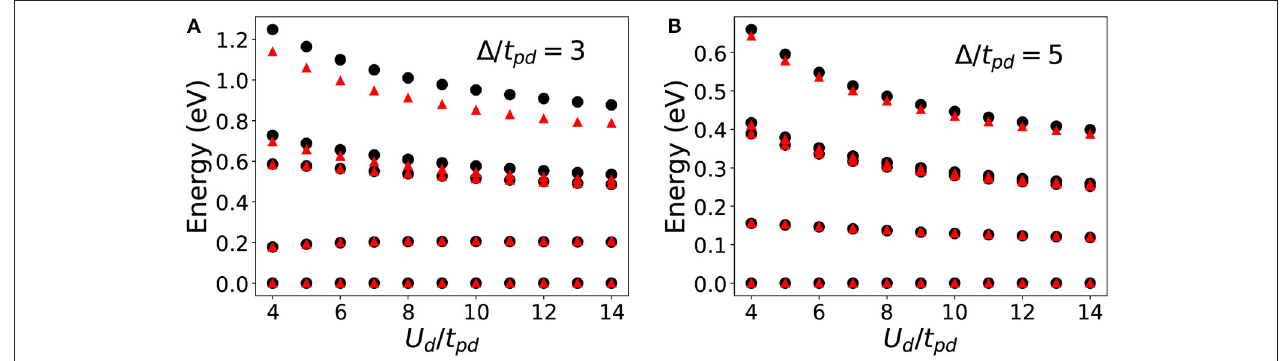
FIGURE 4 | Comparison of energy spectra of the original three-band model (black circles) and the effective one-band model (red triangles). The three-band model is on the 2 2 cell. (A,B) show the energy spectra for different parameter sets of the three-band model: (A) 1/ t pd × U d / t pd . In all cases, t pd 1.3 eV. =